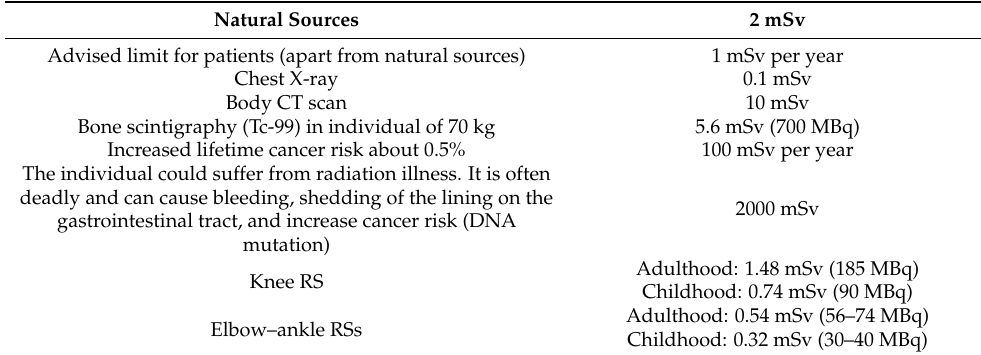
Table 2. Estimation of the dose of radiation of RS in various situations. Notice that the radiation dose of RS is insignificant.